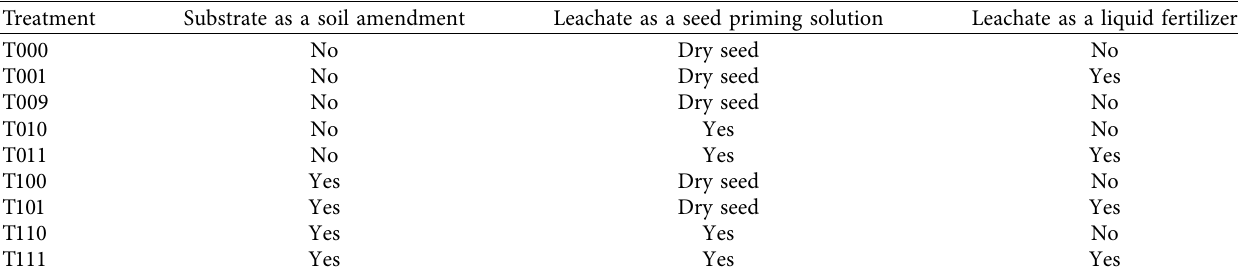
Table 2: The treatments.